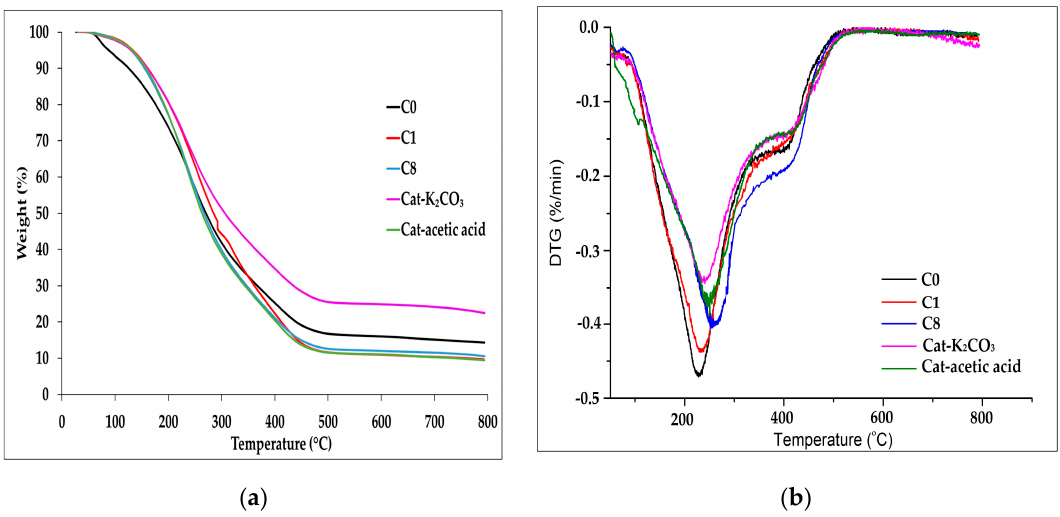
Figure 7. ( a ) Volatility curves of bio-crudes, and ( b ) DTG curves of bio-crudes.